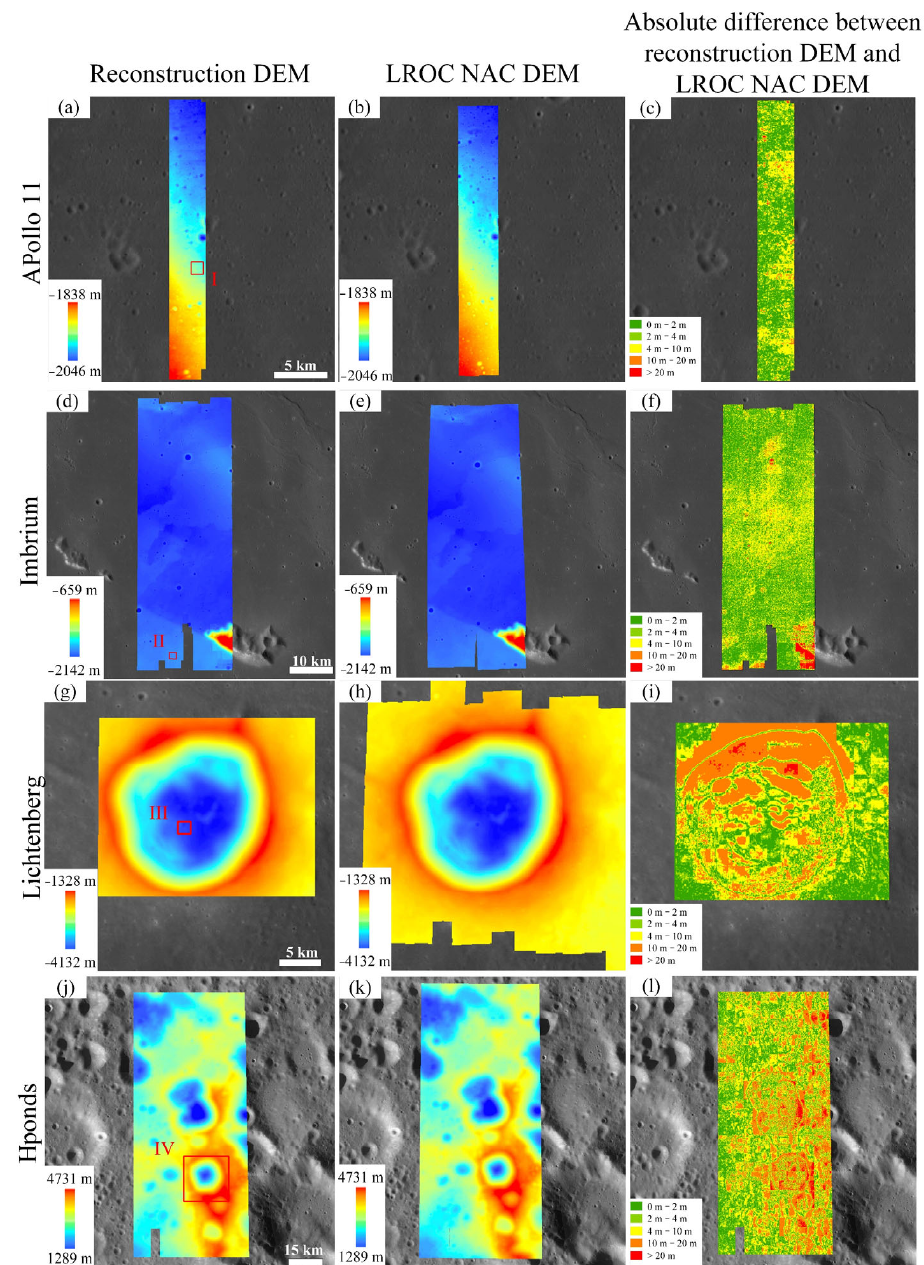
Figure 5. Reconstruction results and comparisons with LROC NAC DEMs. Each row shows one of the four experimental areas. The first column shows reconstruction results; the second column shows LROC NAC DEM as ground truth; the third column shows differences between the reconstruction results and LROC NAC DEMs.